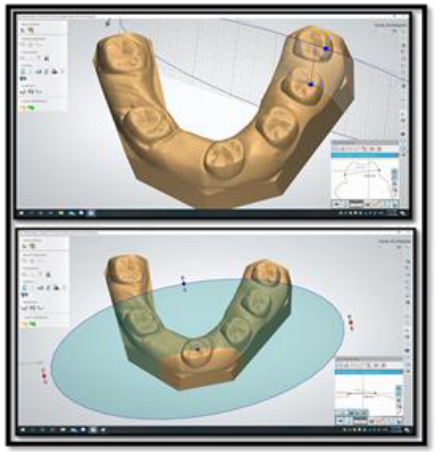
Figure 4: The maxillary and mandibular SSC set